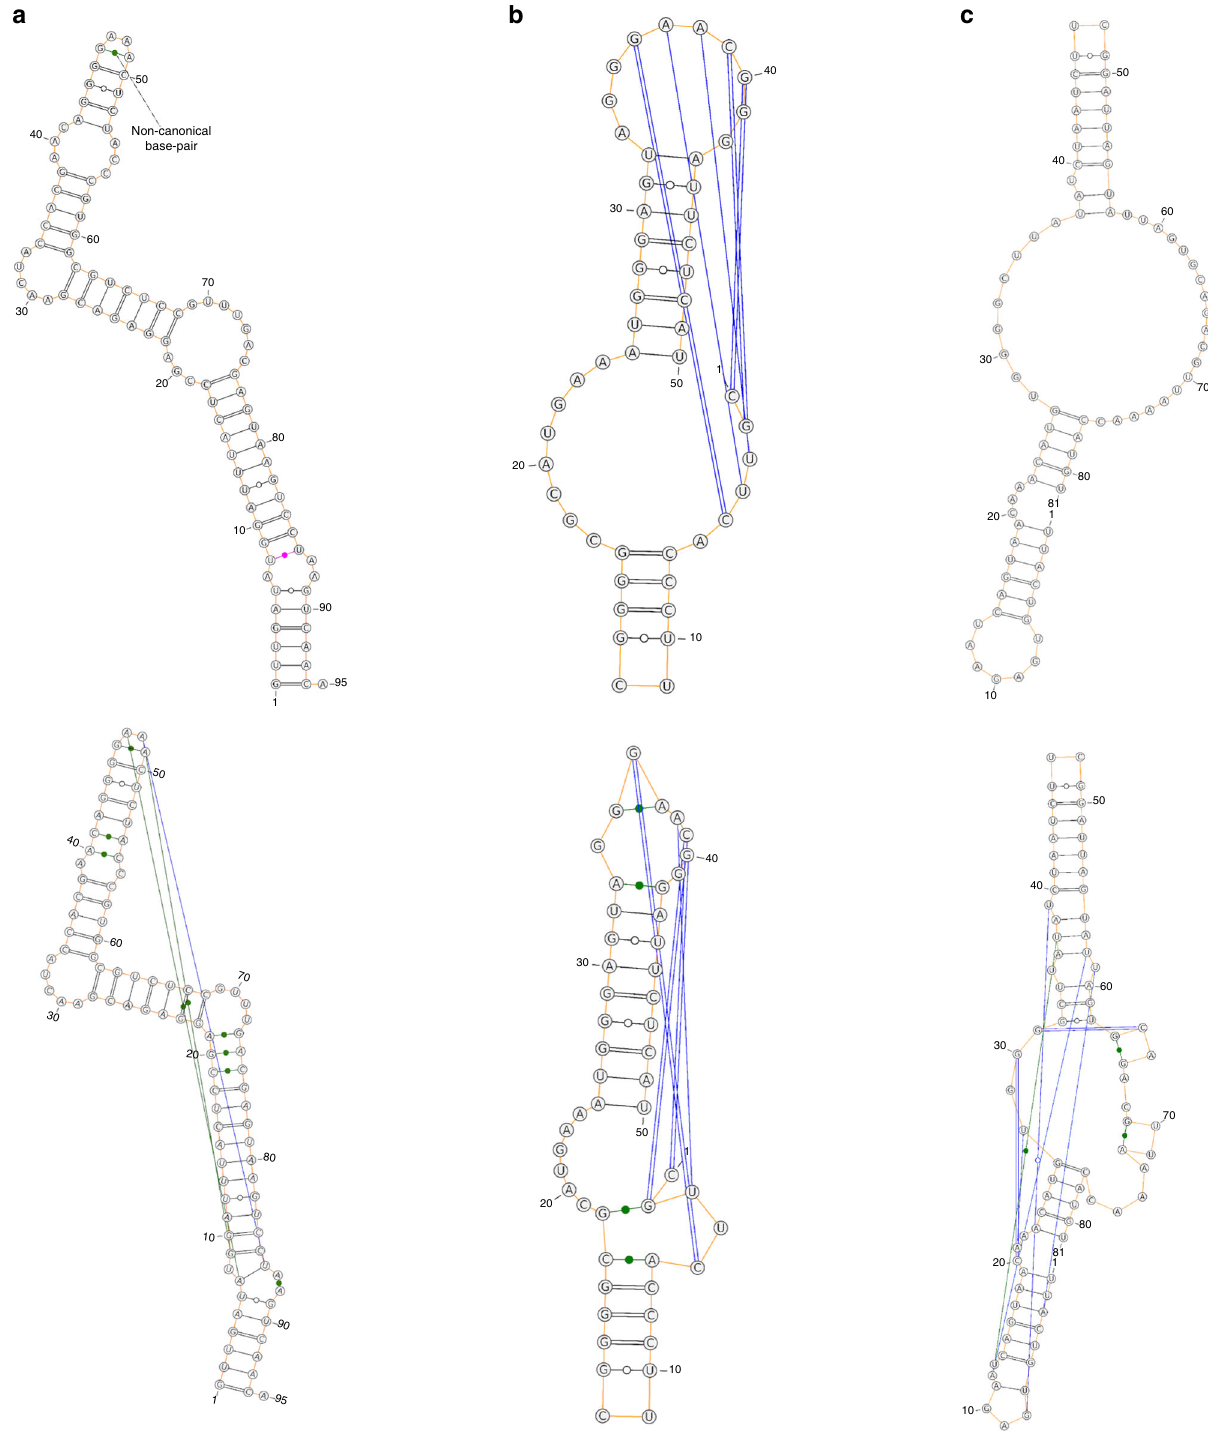
Fig. 4 Comparison of SPOT-RNA prediction with the native structure of a Synthetic Construct, Glutamine II Riboswitch, and Hatchet Ribozyme. The secondary structure of a synthetic construct RNA (chain H in PDB ID 6dvk), the Glutamine II Riboswitch RNA (chain A in PDB ID 6qn3), and Synthetic Construct Hatchet Ribozyme (chain U in PDB ID 6jq6) represented by 2D diagram with canonical base pair (BP) in black color, noncanonical BP in green color, pseduoknot BP and lone pair in blue color, and wrongly predicted BP in magenta color: a predicted structure by SPOT-RNA (at top), with 97 % precision and 77 % sensitivity, as compared with the native structure (at bottom) for the Synthetic Construct RNA, b the predicted structure by SPOT-RNA (at top) with 100 % precision and 81 % sensitivity, as compared with the native structure (at bottom) for the Riboswitch, c the predicted structure by SPOT- RNA (at top) with 100 % precision and 59 % sensitivity, as compared with the native structure (at bottom) for the synthetic construct Hatchet